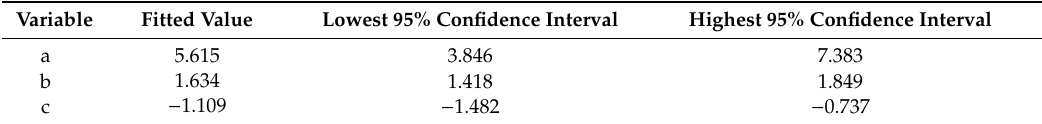
Table 3. confidence intervals for the fitted values of Equation (2).